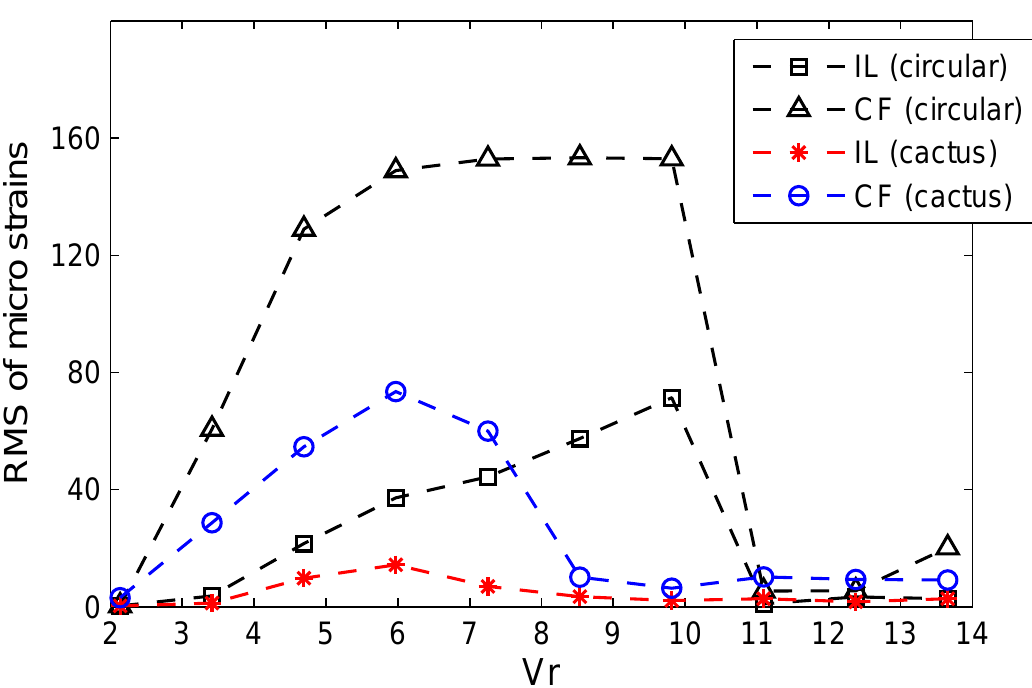
Figure 12. VIV responses of the cactus-shaped cylinder R 8-0.04 and the circular cylinder R 0 at various reduced